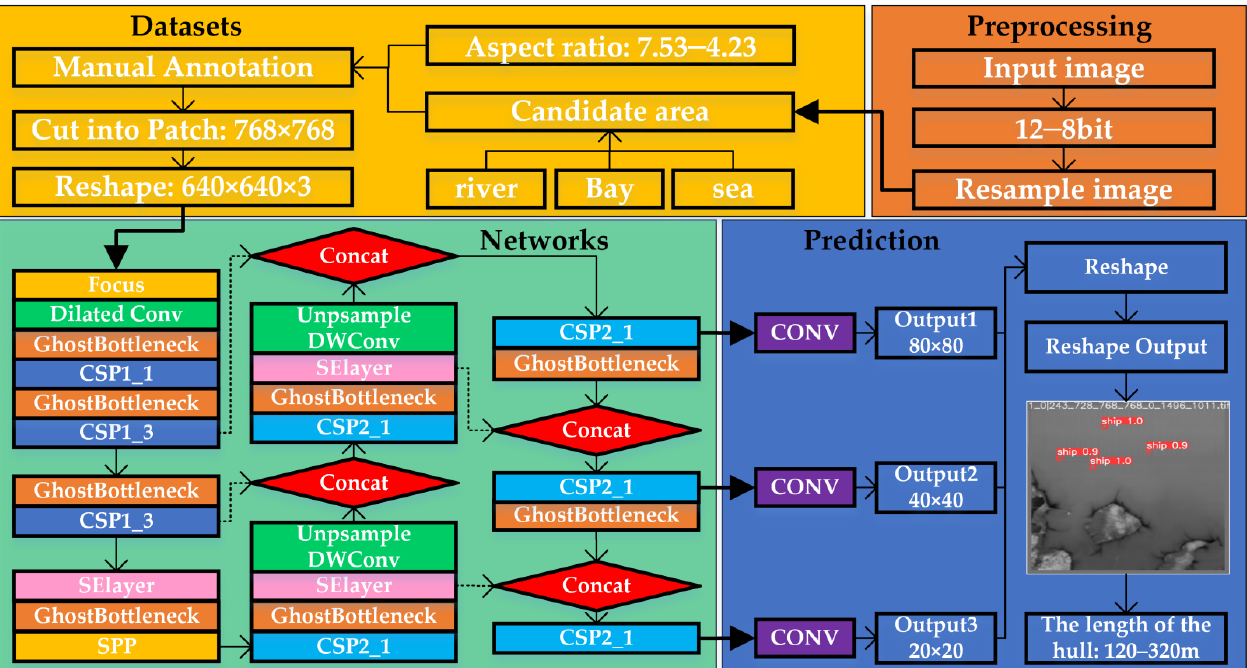
Figure 1. The overall framework of CYSDM: preprocessing, thermal infrared datasets (overcoming intra-class differences), the architecture of networks (the improved lightweight YOLOv5s model), and prediction.